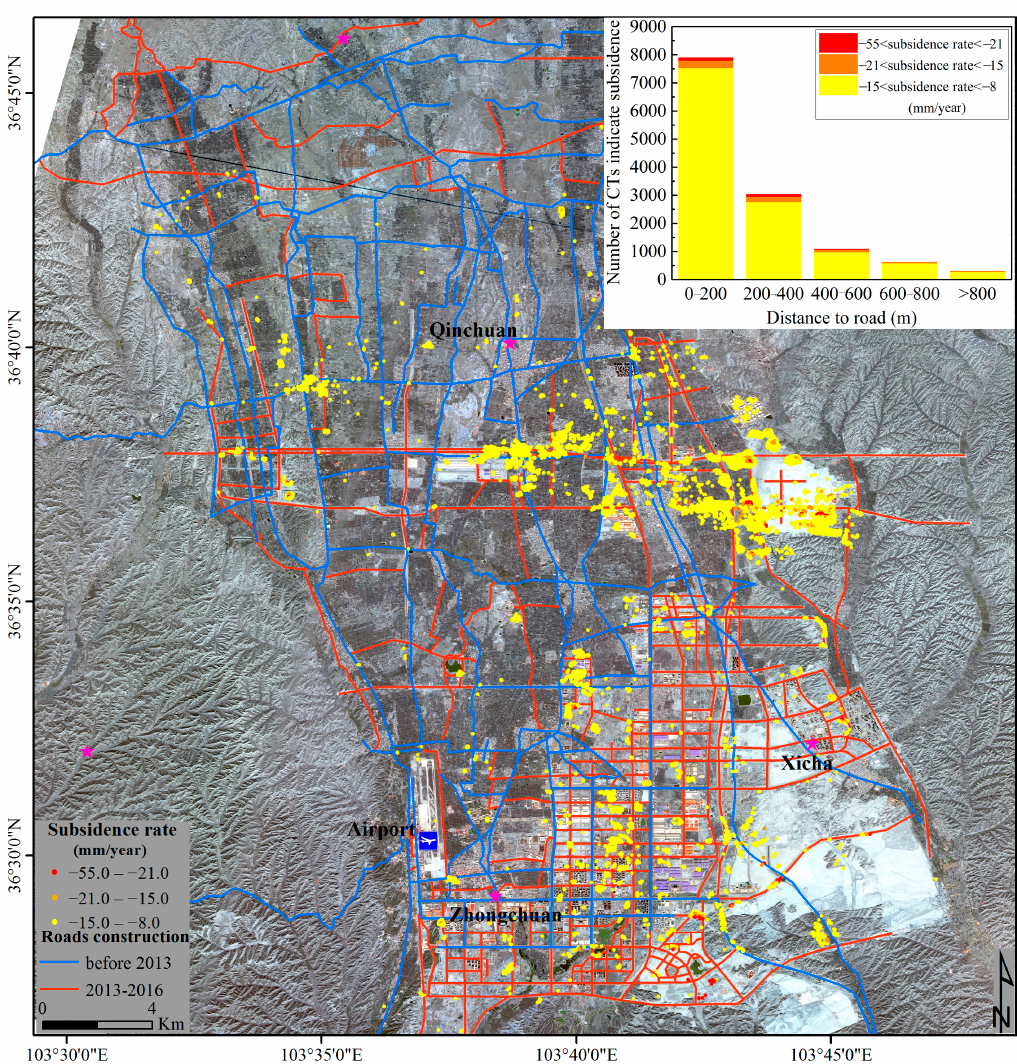
Figure 10. Localized subsidence in relation to road networks in LZND.